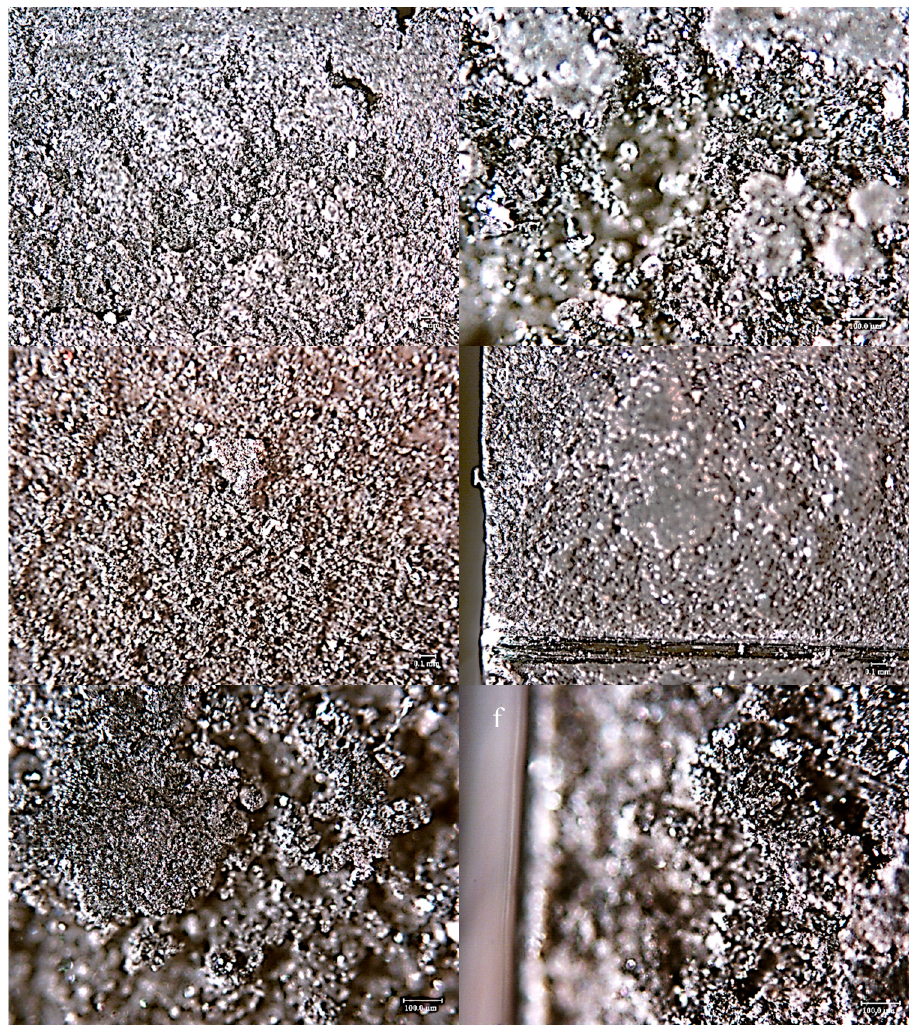
Figure 31. Adhesive 2 lap shear failure surfaces at different extension rates ( a ) 4× magnification at 25 mm/min; ( b ) 10× magnification at 25 mm/min; ( c , d ) 4× magnification at 500 mm/min; ( e , f ) 10× magnification at 500 mm/min.